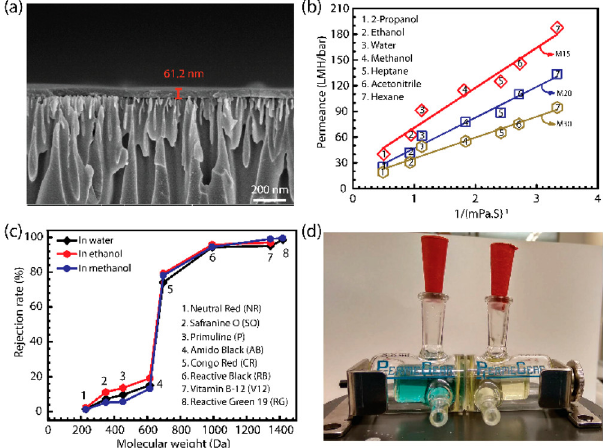
Figure 28. ( a ) Cross-section SEM image of sample M20. ( b ) Permeances of water and a number of polar and nonpolar organic solvents through the three TFP-DHF 2D COF membranes with 15 (M15), 20 (M20), and 30 (M30) layers, plotted with the inverse of their viscosity. ( c ) Rejection rates of various dyes through the M20 membrane vs. their molecular weight. ( d ) Image showing the separation of the mixture dyes of Reactive Green (RG) and Primuline (P). The chamber on the left-hand side contains the mixture of the two dyes, whereas the chamber on the right-hand side is filled with fresh water initially and turned yellow after 1 day of diffusion. Reprinted with permission from [92], Copyright (2018) American Chemical Society.